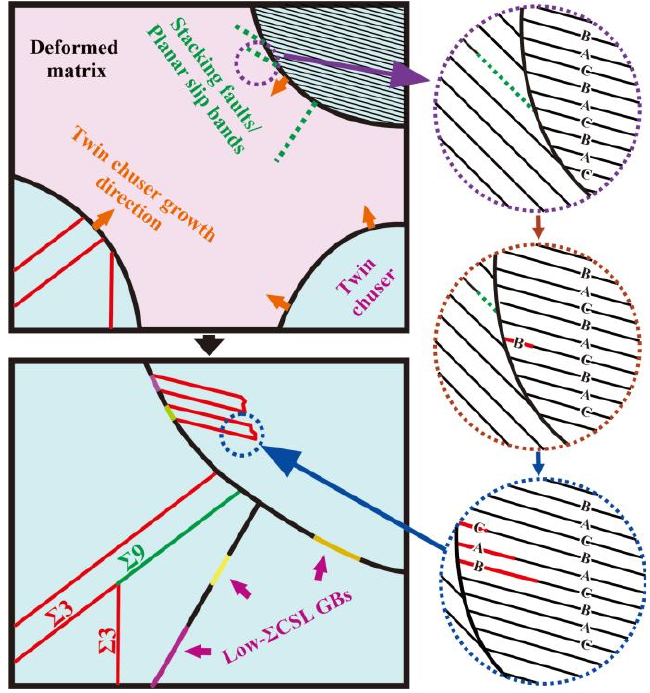
Figure 4. Schematic diagram of the “twin cluster growth” model for the GBCD optimization in FCC metals.